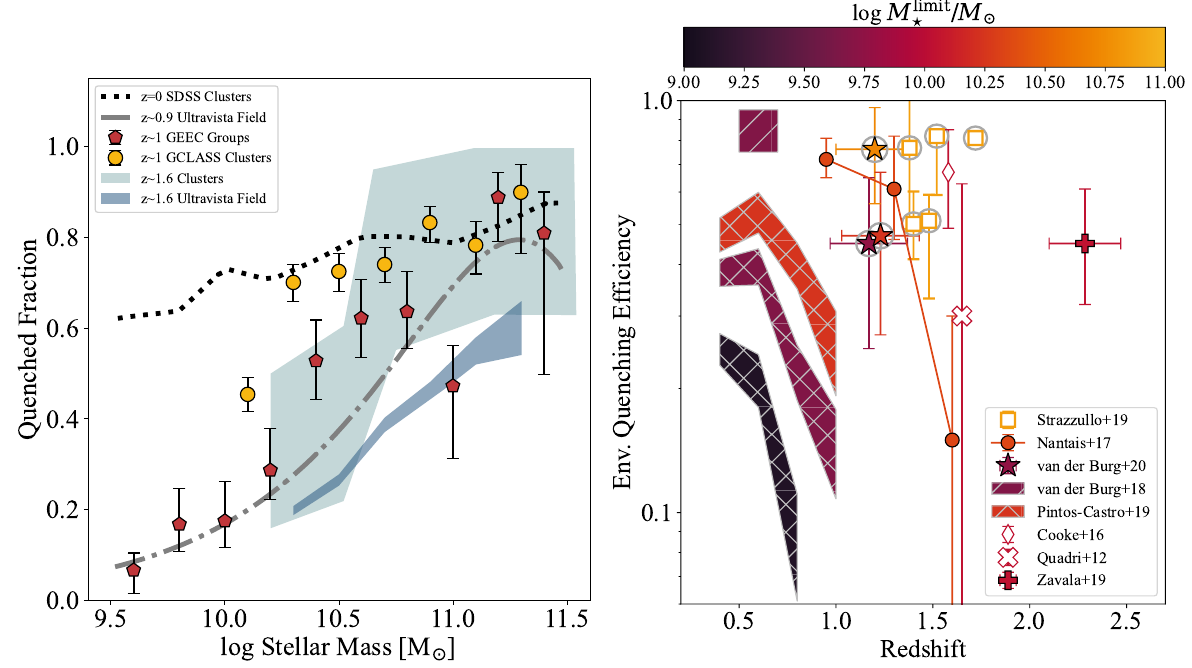
Figure 6. ( left ) The quiescent fraction versus stellar mass of GCLASS clusters and GEEC2 low-mass clusters/groups at z ∼ 1 (yellow circles and red pentagons; Balogh et al. [35]) compared to three clusters at z ∼ 1.6 (green shaded region; Lee-Brown et al. [415]). Comparisons are made to coeval field samples from UltraVISTA (dash dot line at z ∼ 1 and blue shaded region for z ∼ 1.6). Local SDSS clusters are also shown, demonstrating that the SFR-density relation is in place at z ∼ 1 for log M (cid:63) / M (cid:12) (cid:38) 10.3 cluster galaxies. The comparison between GCLASS clusters and GEEC2 low- mass clusters/groups reveals a halo mass dependence, while the comparison of clusters at z ∼ 1 and z ∼ 1.6 shows a redshift and stellar mass dependence. ( right ) The environmental quenching efficiency in massive (proto-)clusters as a function of redshift. The stellar mass limit of each sample is denoted by the color scale. Closed symbols and regions contain multiple clusters, while open symbols are single clusters. Gray hatches and circles mark (cid:101) env measured within r ∼ 0.5 R 200 ; all others are within r ∼ R 200 . Strong stellar mass [388,407] and redshift [407,416] dependencies are observed in cluster surveys. A halo mass dependency is also suggested by the comparison of Planck clusters (log M 200 / M (cid:12) ∼ 15; [397]) to the SpARCS and GOGREEN surveys (log M 200 / M (cid:12) ∼ 14.5; [388,407]). Quenched high-mass populations can be found in clusters out to z ∼ 1.7 [417] and in proto-clusters at z ∼ 2–2.5 [346]. Figures adapted from Figure 3 in Balogh et al. [35], Figure 7 in Lee-Brown et al.